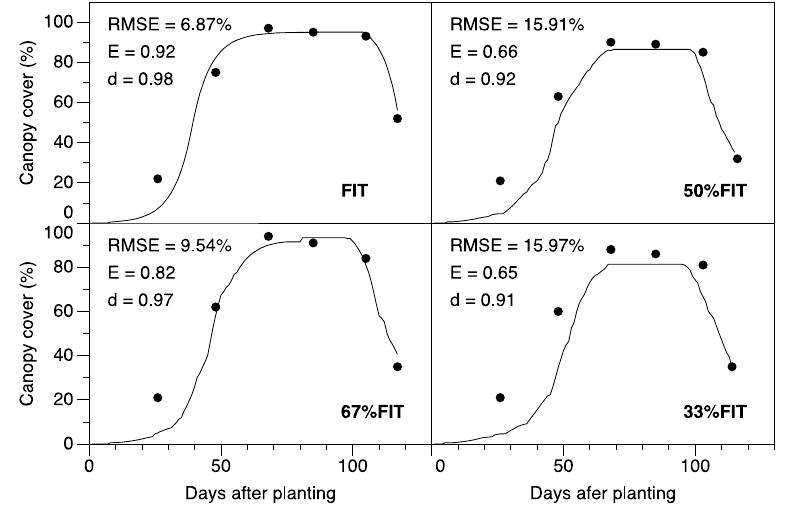
Figure 5. Simulated and measured canopy cover for the four irrigation treatments in Experiment 1 used in model validation.